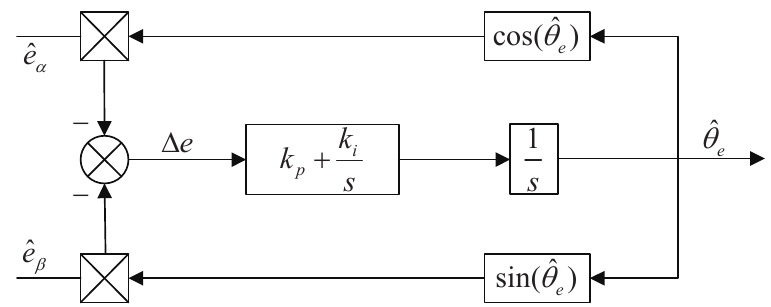
Figure 3. Structure of conventional PLL.